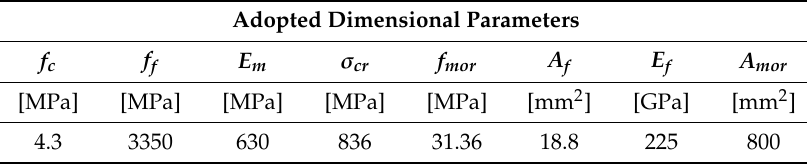
Figure 10. Numerical bending moment–curvature diagrams. Table 3. Dimensional parameters, adapted from Papanicolaou et al. [38].